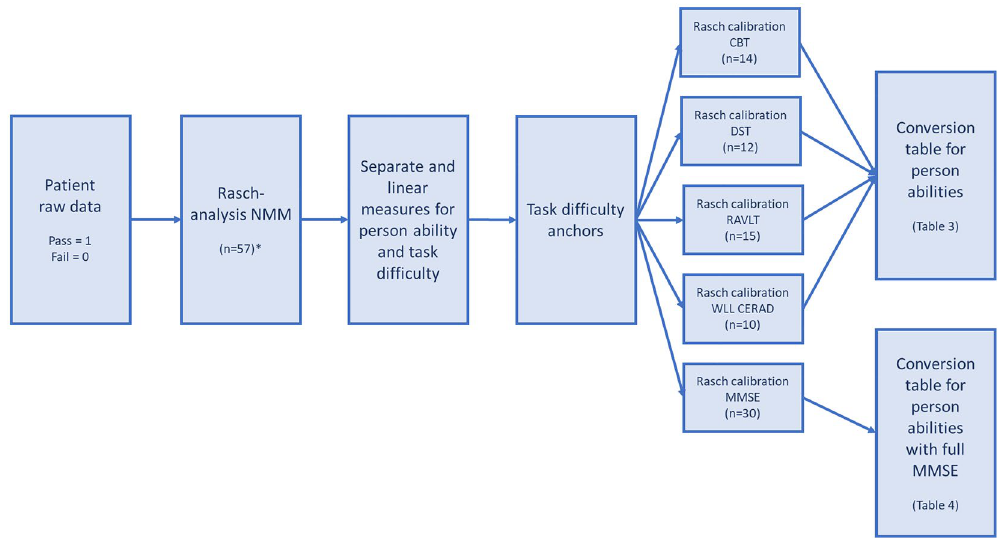
Figure 1. Flow-chart of raw data processing via the Rasch analysis and calibration into conversions tables and crosswalks for score-to-measures. * The full MMSE is not included in the NMM, thus, 57 is a sum of all items from other legacy tests (CBT n = 14, DST = 12, RAVLT n = 15 and WLL CERAD n = 10) and the six memory items from